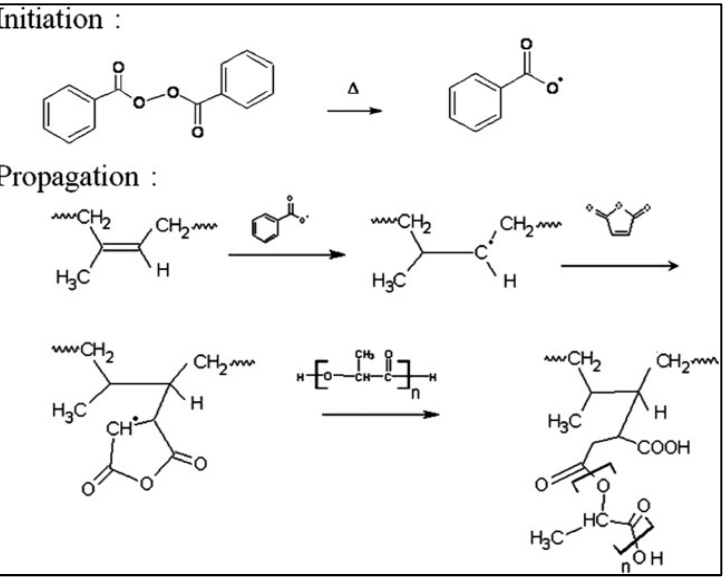
Figure 10. Proposed mechanism for the grafting of NR-MA on PLA (from Thepthawat et al. [47], copyright Wiley-VCH GmbH. Reproduced with permission). copyright Wiley-VCH GmbH. Reproduced with